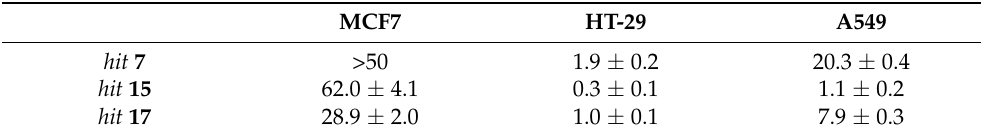
Table 1. Cytotoxicity CC 50 ( µ M) in human tumor cell lines measured 48 h post administration of hits 7 , 15, and 17